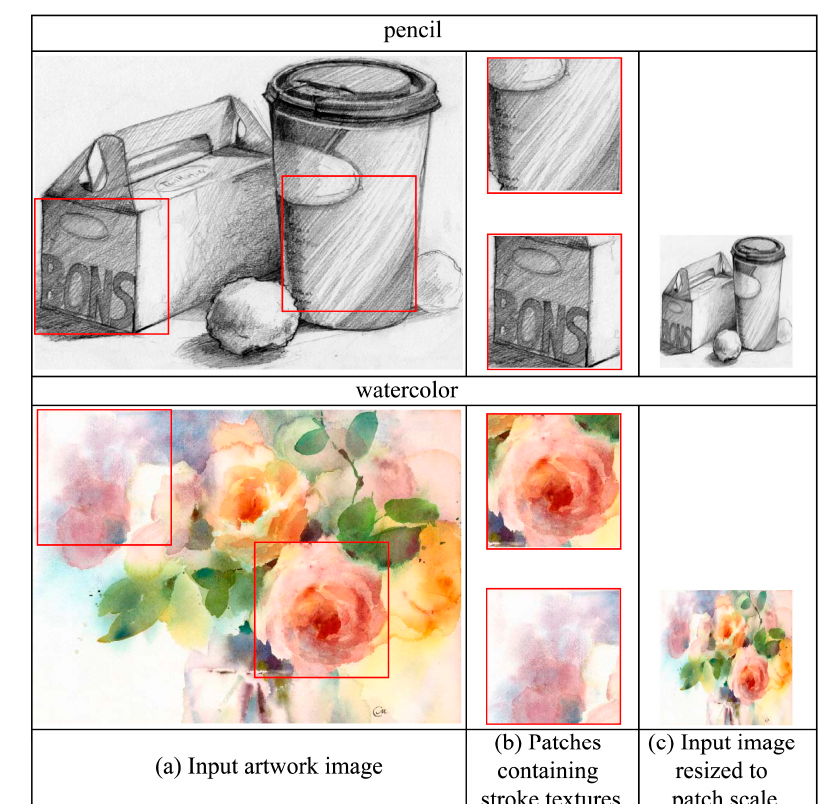
Figure 2. Patches containing stroke textures for pencil and watercolor artwork ( a ) Input artwork image; ( b ) patches containing stroke textures; ( c ) input image resized to patch